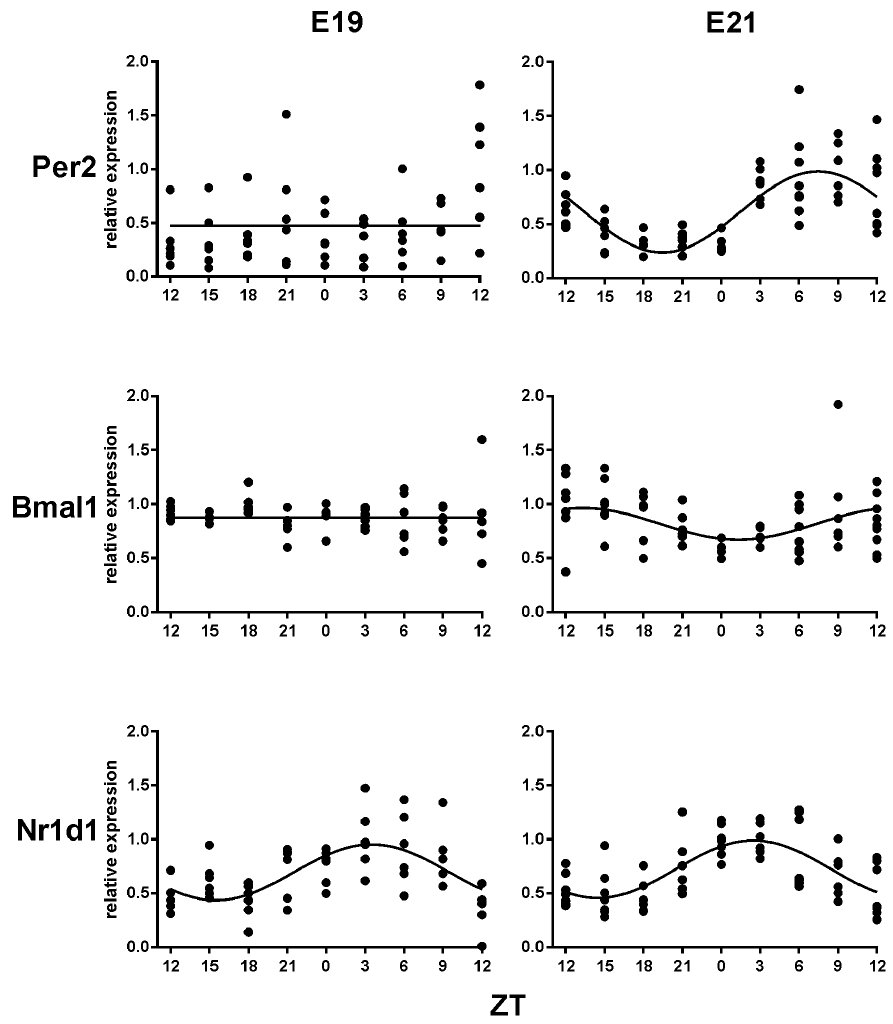
Figure 2. Clock gene expression profiles in the fetal rat SCN. 24-h profiles of clock gene ( Per2 , Bmal1 and Nr1d1 ) expression were detected at embryonic day 19 (E19) (left column) and embryonic day 21 (E21) (right column). Relative expression levels of the clock genes in the individual SCN are shown. The data were analyzed with cosinor analysis and the presence of significant circadian variation in the transcript levels is denoted by a cosine curve whereas its absence is denoted by a straight line. For details, see Materials and Methods. Time is presented as Zeitgeber time (ZT); ZT0 corresponds to the time of lights-on and ZT12 to lights-off.